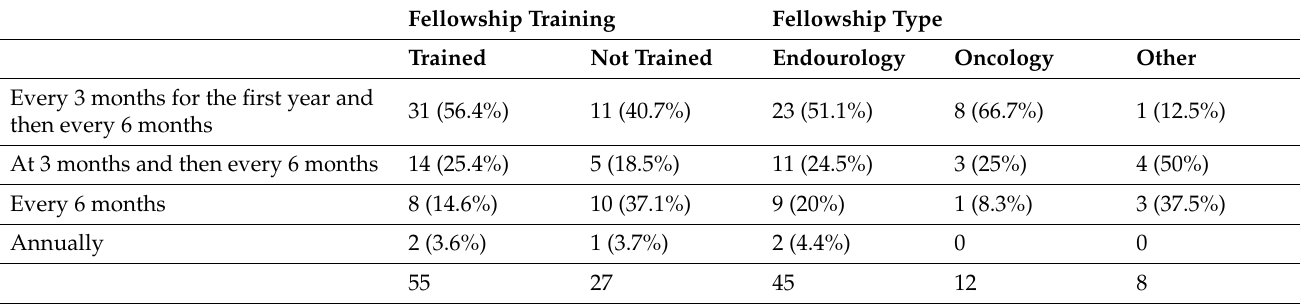
Table 3. Association between surgeon training/experience and voiding cytology test regimen.